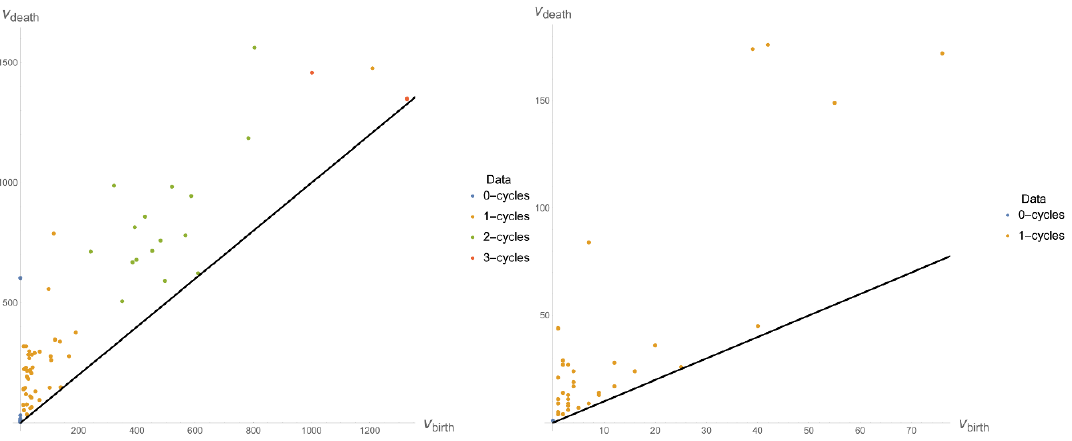
Figure 4 . Persistence diagram for the population in the initial (left) and (cid:12)nal (right) generation in (cid:13)ux